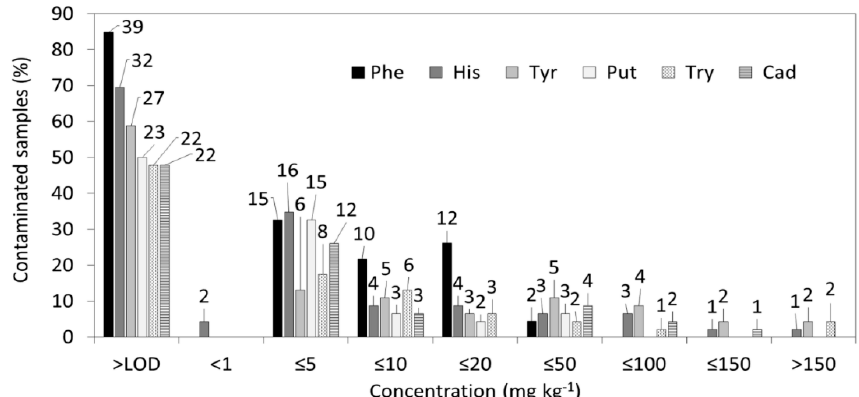
Figure 2. The relative distribution of blue mould cheese contamination with biogenic amines (count of positive samples for each biogenic amine is shown above each bar diagram.